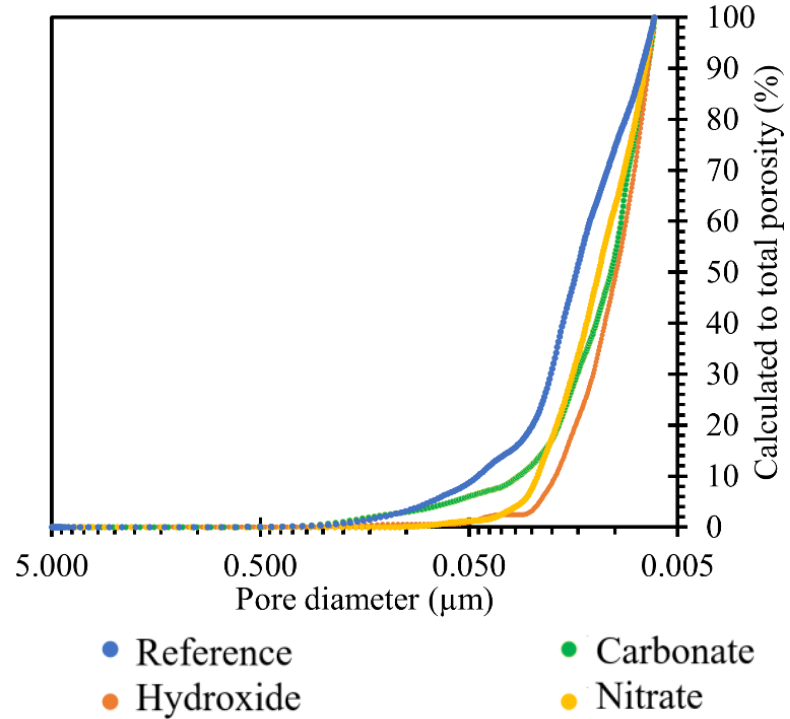
Figure 10. Results of comparison of TS porosity after 120 days of exposure in the respective sodium environment at 40 °C.